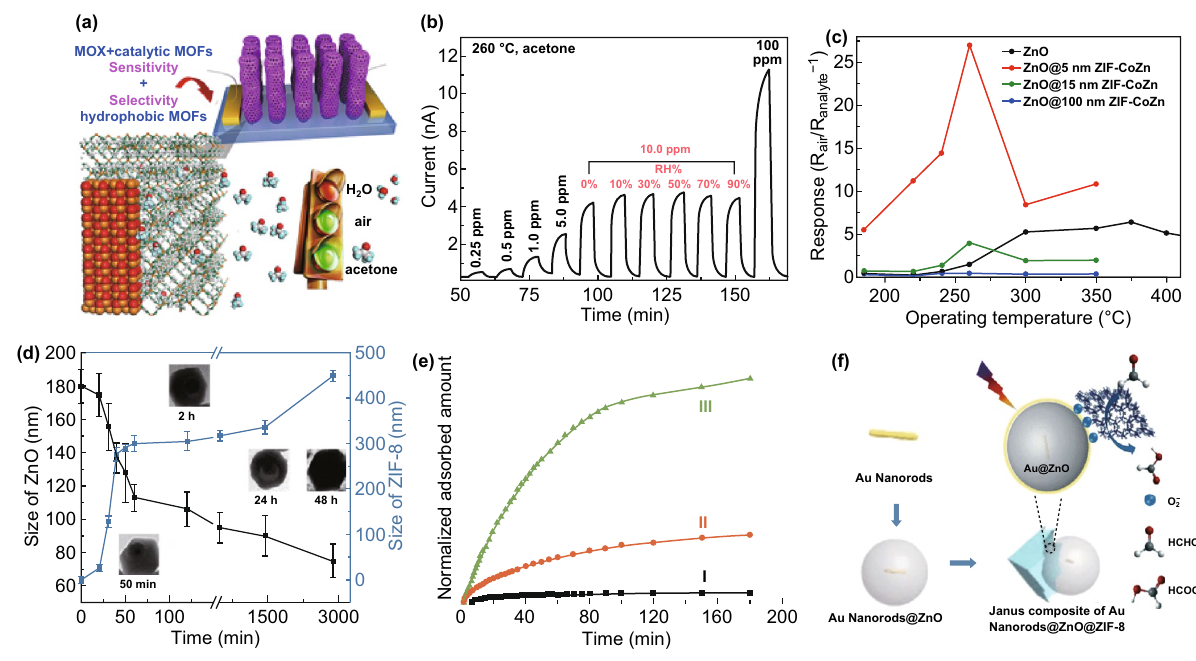
Fig. 20 a Schematic illustration of ZnO@ZIF-CoZn core-sheath NWAs sensor; b Response-recovery curves to acetone at different concentra- tions in dry air and in 10 ppm acetone with different relative humidity and at 260 °C; and c temperature-dependent responses of ZnO@5 nm ZIF-CoZn. Reproduced with permission [76]. Copyright 2016, Wiley–VCH. d Plots of Au@ZnO and Au@ZnO@ZIF-8 size versus time; insets are the representative TEM images of the products at specific times. e Kinetics of HCHO adsorption (solid symbols). f Proposed mechanism of oxidation of HCHO into HCOOH. Reproduced with permission [77]. Copyright 2018, Springer